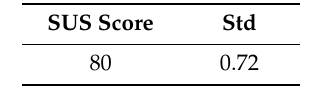
Table 2. System usability scale (SUS) results ( n =